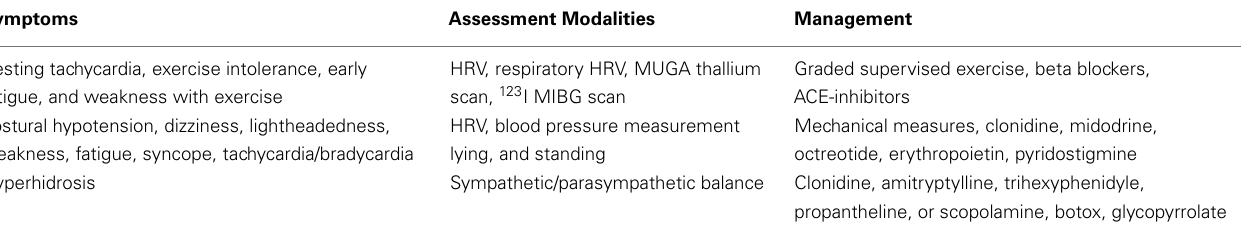
Table 4 | Diagnosis and management of autonomic